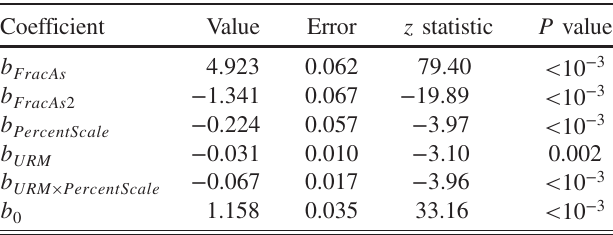
TABLE IV. The coefficients from an HLM fit to Eq. (3) are shown along with their standard errors, z statistics, and P values. One sees that the URM grade penalty due to percent-scale grading (compared to 4-point scale grading) is about the same after controlling for physics understanding as it was without that control. At the student level this model has SBR 2 ¼ 0 . 70 with SBR 2 ¼ 0 . 16 at the class